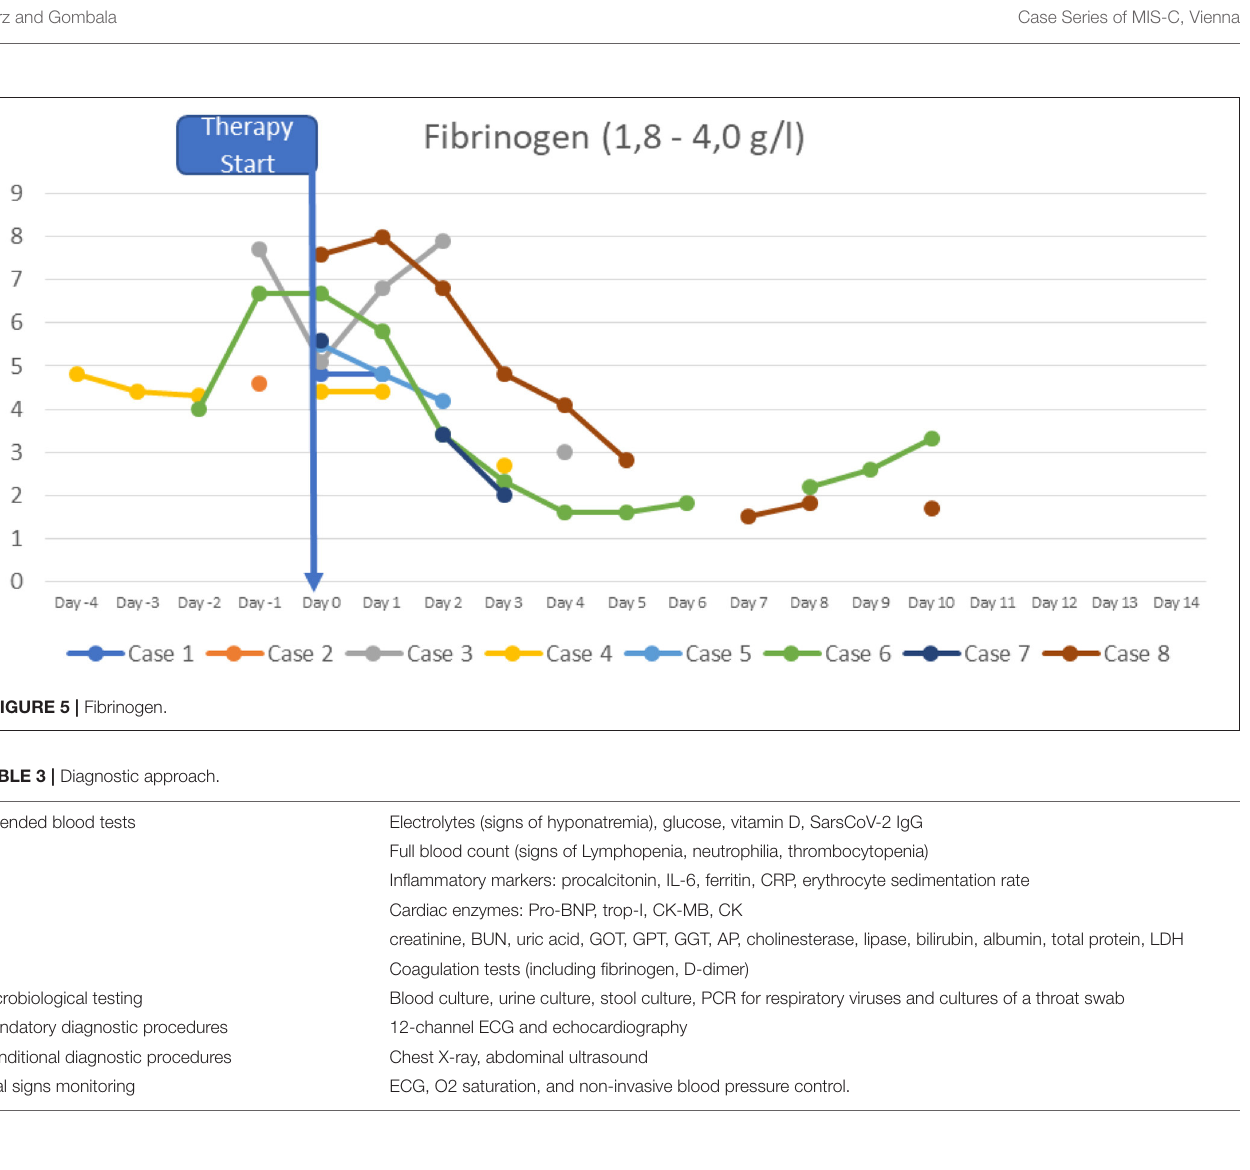
TABLE 4 | Therapy